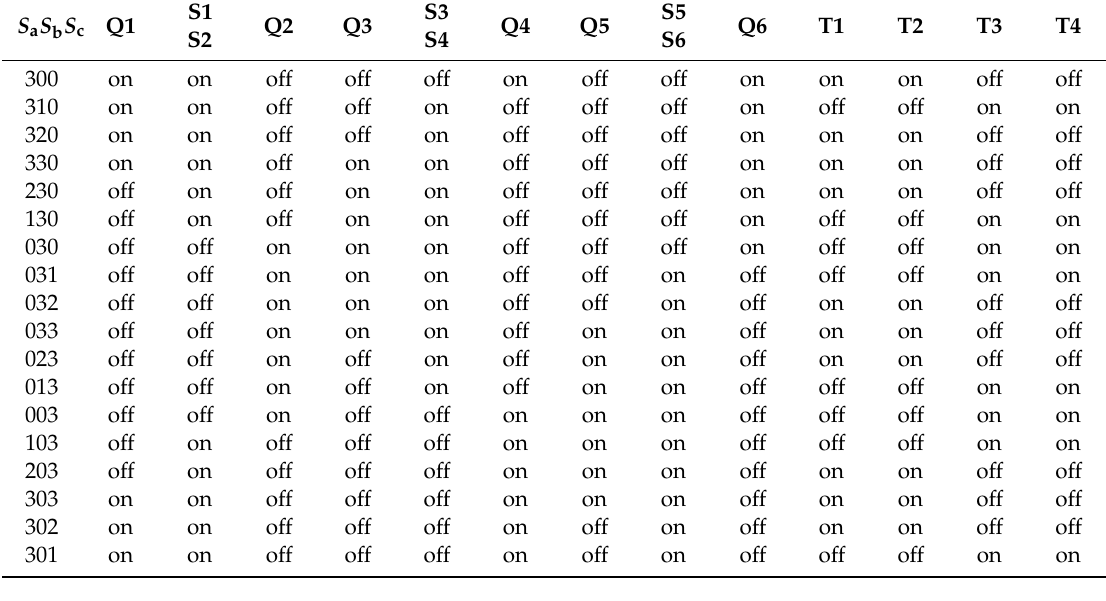
Table 2. Voltage transition and switching states over 1 cycle with reduced switching transitions.